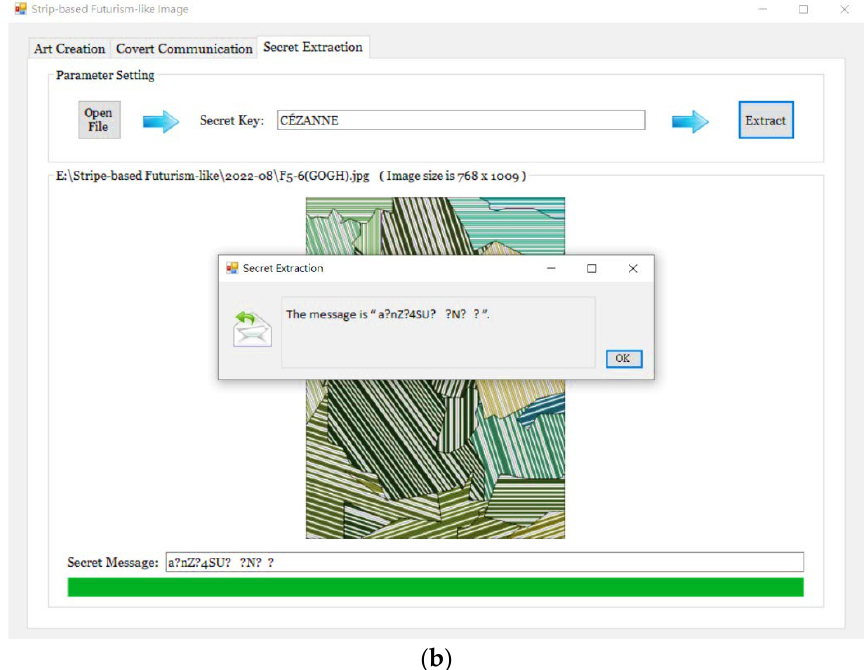
Figure 18. An illustration of extracting an erroneous secret message from the stego-image using an incorrect secret key “CÉZANNE”. ( a ) The stego-image with the stripe width of 6 pixels shown in Figure 14e. ( b ) The erroneous hidden data extraction result.